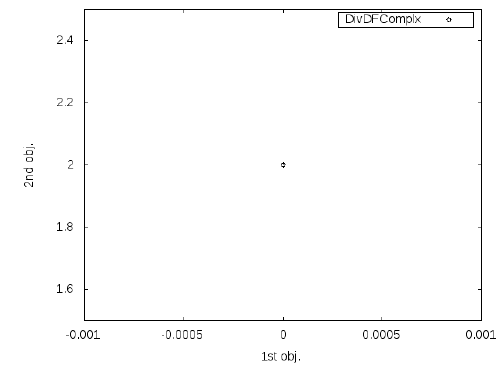
Fig. 5. The Pareto front approximation obtained for abalone using fitness function 2e (objective 1 stands for double fault and objective 2 for